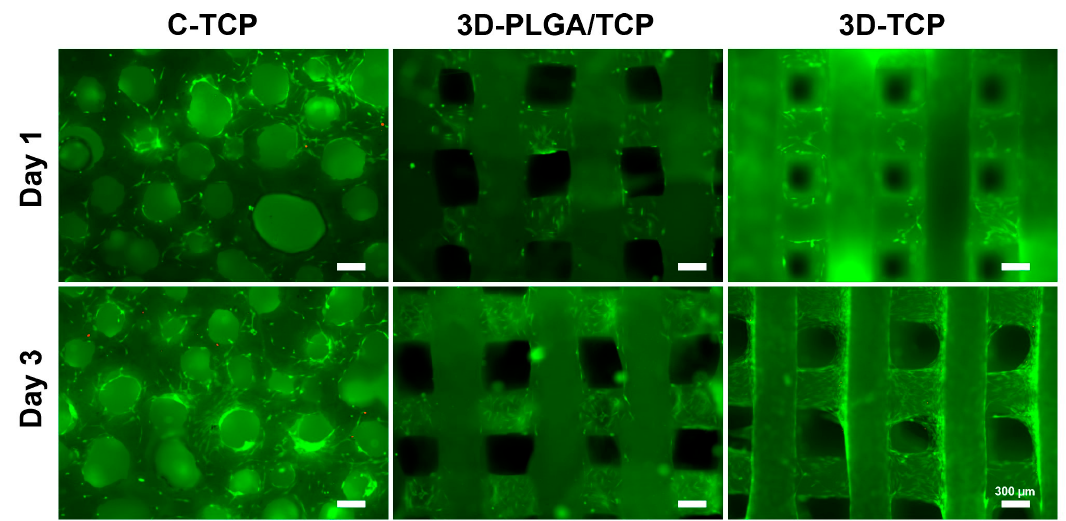
Figure 4. The e ff ect of C-TCP, 3D-PLGA / TCP, and 3D-TCP sca ff olds on hDPSCs viability. The live / dead assay results indicated that hDPSCs possessed excellent cell viability on the surfaces of all tested sca ff olds (green: live cells; red: dead cells).